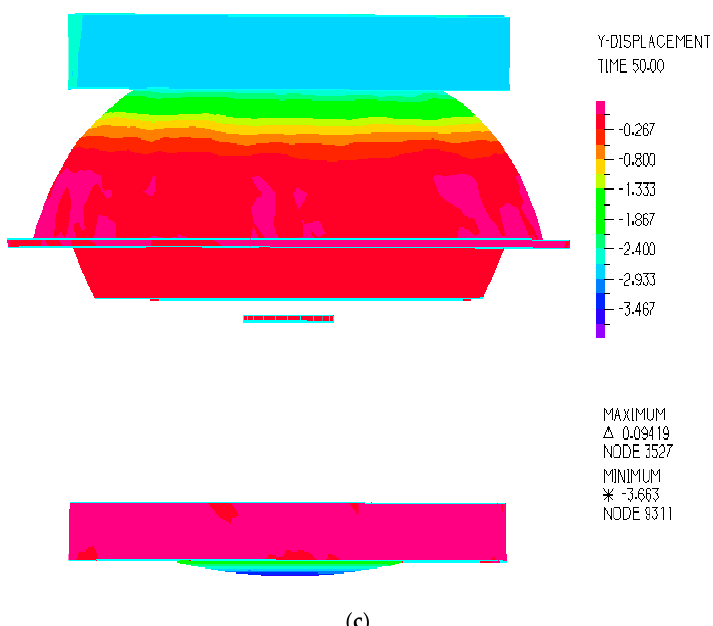
Figure 11. Displacement cloud diagram of the suspended structure.( a ) Non-creep displacement map. ( b ) 2.98 mm creep displacement cloud map. ( c ) Creep displacement cloud map of 3.83 mm.